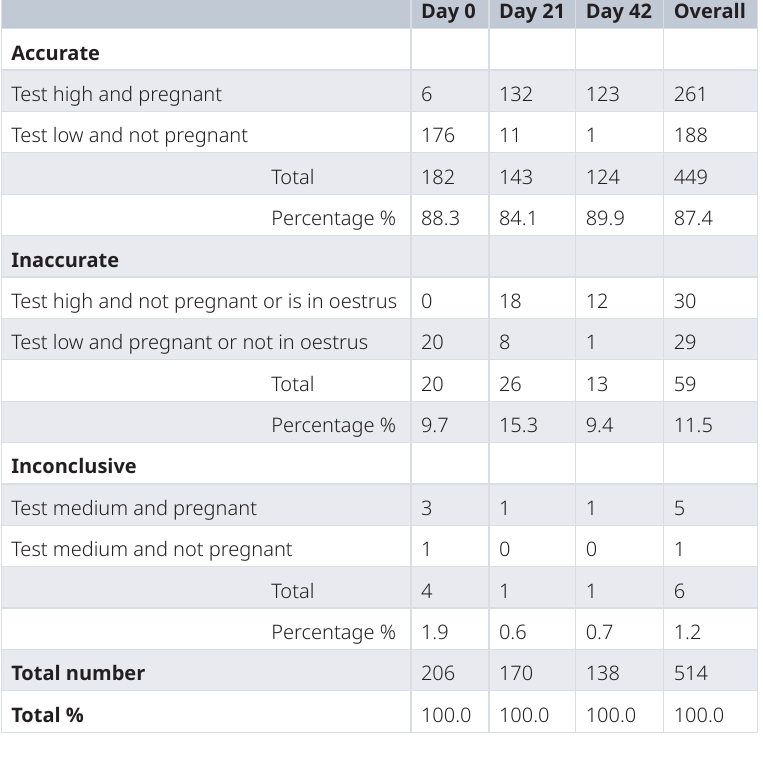
Table 4. Conception rates for